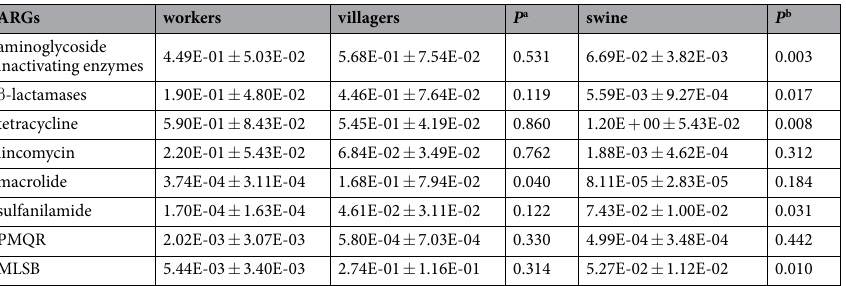
Table 1. Relative abundance of ARGs in swine, farm workers and local villagers. All data were normalized to ambient 16S rRNA copies. a Indicated the P values between the workers and villagers. b Indicated the P values between the human (workers and villagers) and